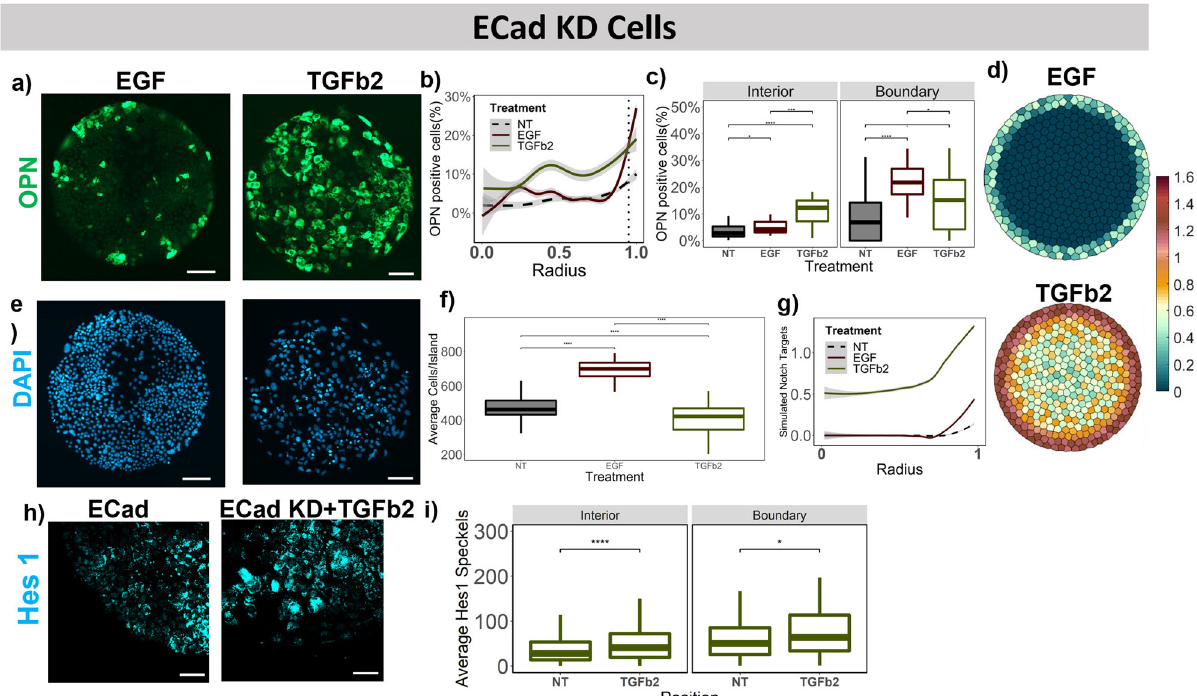
Fig. 8 Effect of extrinsic growth factor treatments in conjunction with E-Cadherin siRNA knockdown. a Representative fl uorescent Images of EGF and TGF β 2 treated ECad KD BMELs on Col 1 microarrays on 25 kPa polyacrylamide hydrogels. Green: OPN, Blue: DAPI. Scale Bar: 100 μ m. b Quanti fi cation of average percent OPN + cells/island as a function of the radius. 0 is center, 1 is the edge, vertical dashed line at radius = 0.95. c Quanti fi cation of average percent OPN + cells/island in the interior (radius = 0 – 0.95) and at the boundary (radius = 0.95 – 1.00). e DAPI fl uorescent Images for EGF and TGF β 2 treated ECad KD BMELs on circular microarrays. Scale Bar: 100 μ m. f Quanti fi cation of Average Cell Number per individual island for EGF and TGF β 2 treated ECad KD BMELs. d Simulated Notch target genes on cells on a circular lattice, with in silico growth factor treatments and E-Cadherin knockdown. Heatmap color: arbitrary unit for Notch target genes. g Quanti fi cation of simulated Notch target genes in cells on a circular lattice for the in silico growth factor treatments and ECad KD. h ISH-HCR quanti fi cation of Hes1 mRNA, 40X confocal maximum intensity projection of ECad KD BMELs with and without TGF β 2 on circular islands. i Quanti fi cation of average Hes1 mRNA speckles for images in 7h on the boundary versus the interior. Boxplots —‘ . ’ : ns; * p -value < 0.05; ** p -value < 0.01; *** p -value < 0.001 **** p -value < 0.0001, calculated using Wilcox test in R. Line plots — Gray: 95% con fi dence interval. n ≥ 4 biological replicates (independent experiments) and n ≥ 15 technical replicates (individual islands). The No Treatment Control (NT) for the Ecad KD BMELs is referred from Fig. 4b, c for statistical